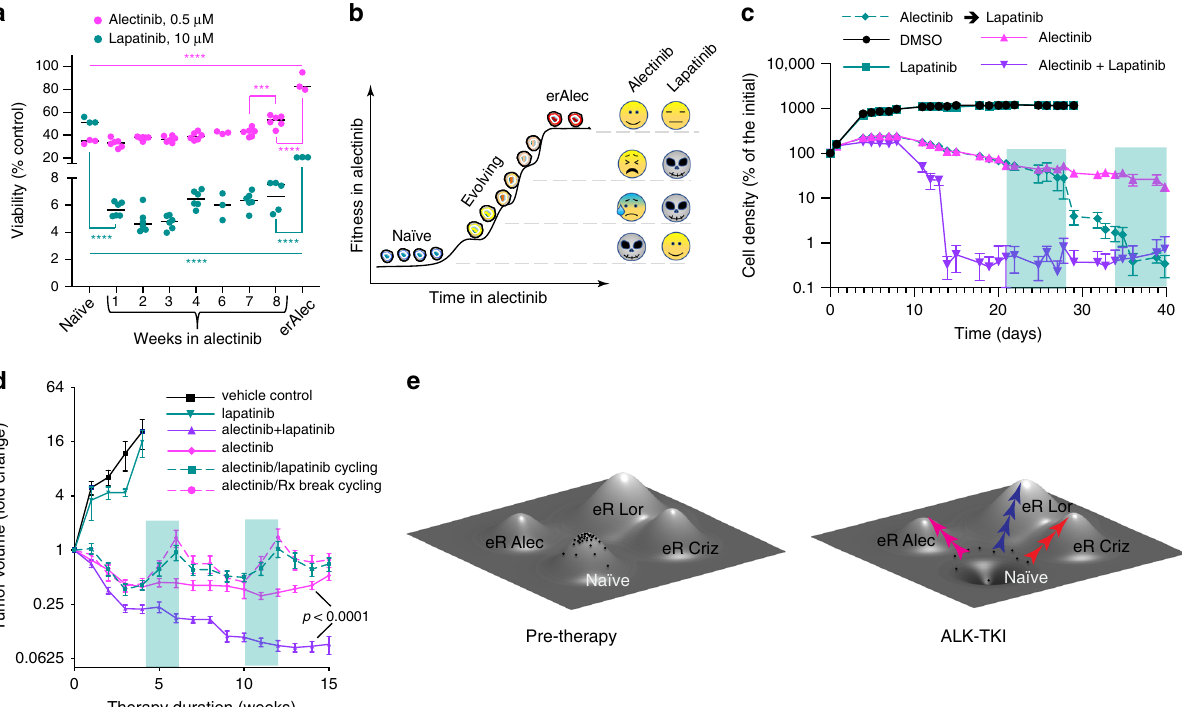
Fig. 6 Collateral sensitivities of evolutionary intermediates. a Impact of pre-exposure to 0.5 µ M alectinib for the indicated periods on sensitivity to alectinib and lapatinib, measured by Cell Titer Glo assay. One-way ANOVA was used for both drugs ( p < 0.0001). Adjacent time points were compared using Sidak ’ s multiple comparison tests (*** p < 0.001 and **** p < 0.0001). Mean ± SD of experimental replicates are shown. n = 3, representing separate wells, for naive control and erAlec H3122 cells. n = 6 wells (3 wells each of 2 biological replicates) for cells pre-exposed to alectinib. Data for one of the biological replicates is missing in week 6. b Illustration of association of evolving resistance to alectinib with collateral sensitivity to lapatinib. c Lapatinib can prevent the development of resistance to alectinib in vitro, both as a combination treatment, or in drug cycling. Green shading indicates switching from alectinib to lapatinib monotherapy. Residual signal in the combination therapy and cycling groups re fl ects auto fl uorescence, as visual examination revealed lack of surviving tumor cells. Mean ± SD of experimental replicates ( n = 3 representing separate wells for DMSO and lapatinib monotherapy, n = 6 for the remaining groups) are shown. d Change in volume of H3122 xenograft tumors treated with indicated therapies; treatment was initiated 3 weeks post tumor implantation. Green shading indicates switching from alectinib to lapatinib monotherapy or vehicle control. Mean values ± SE are shown; n = 6 for lapatinib monotherapy, n = 10 for alectinib monotherapy, switching between alectinib and lapatinib, and alectinib/lapatinib combination, n = 9 for vehicle control, replicates represent separate tumors. e Evolving resistance interpreted through a fi tness landscape metaphor. Naive cells occupy a local fi tness peak. Drug exposure reshapes the landscape, turning this fi tness peak into a fi tness trough. Different ALK inhibitors act on partially distinct outliers, directing their evolution toward distinct fi tness